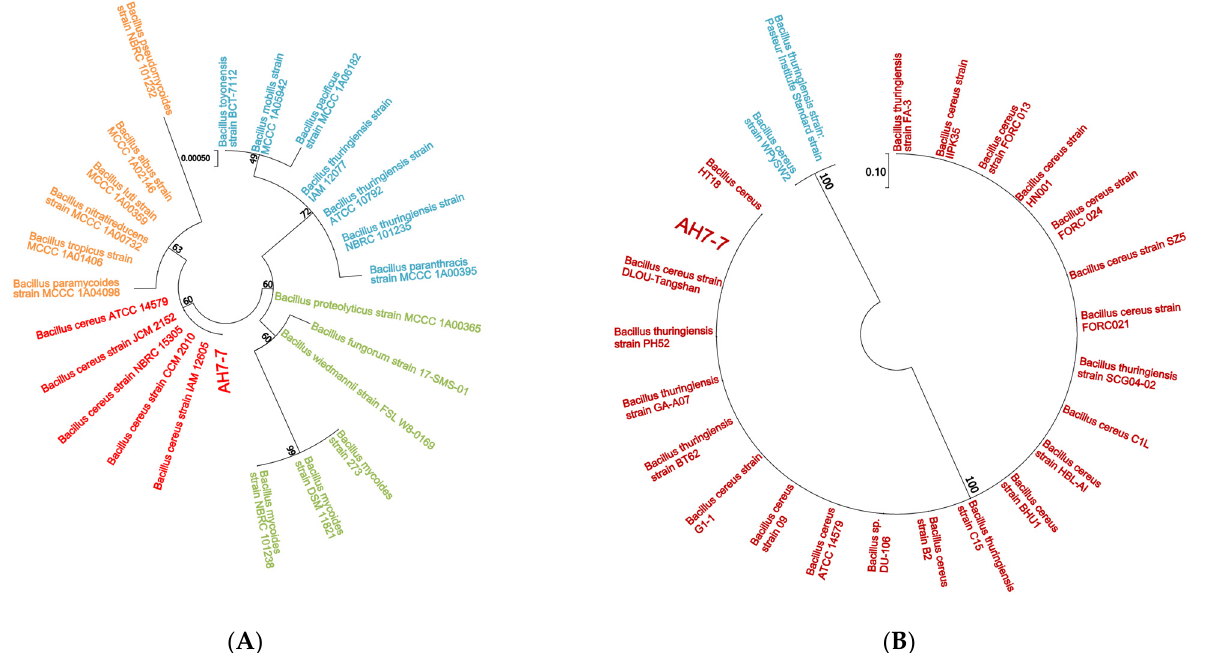
Figure 2. Phylogenetic tree of strain AH7-7. ( A ) 16S rRNA; ( B ) gyrB.